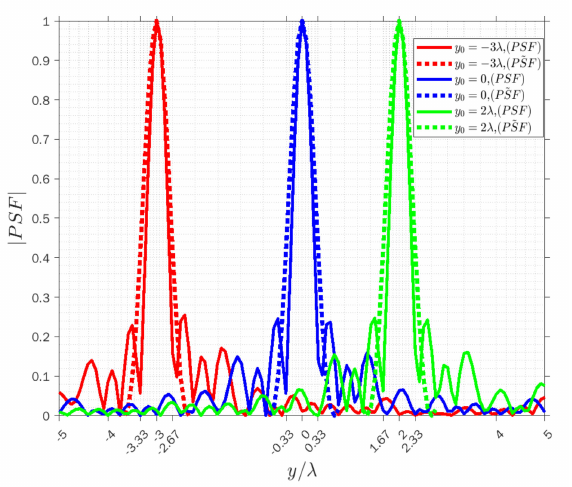
Figure 5. Comparison of the normalized amplitude of the actual (solid lines) and approximated (dashed lines) PSFs for y 0 = − 3 λ (red lines), y 0 = 0 (blue lines) and y 0 = 2 λ (green lines) when x = − λ in transmission